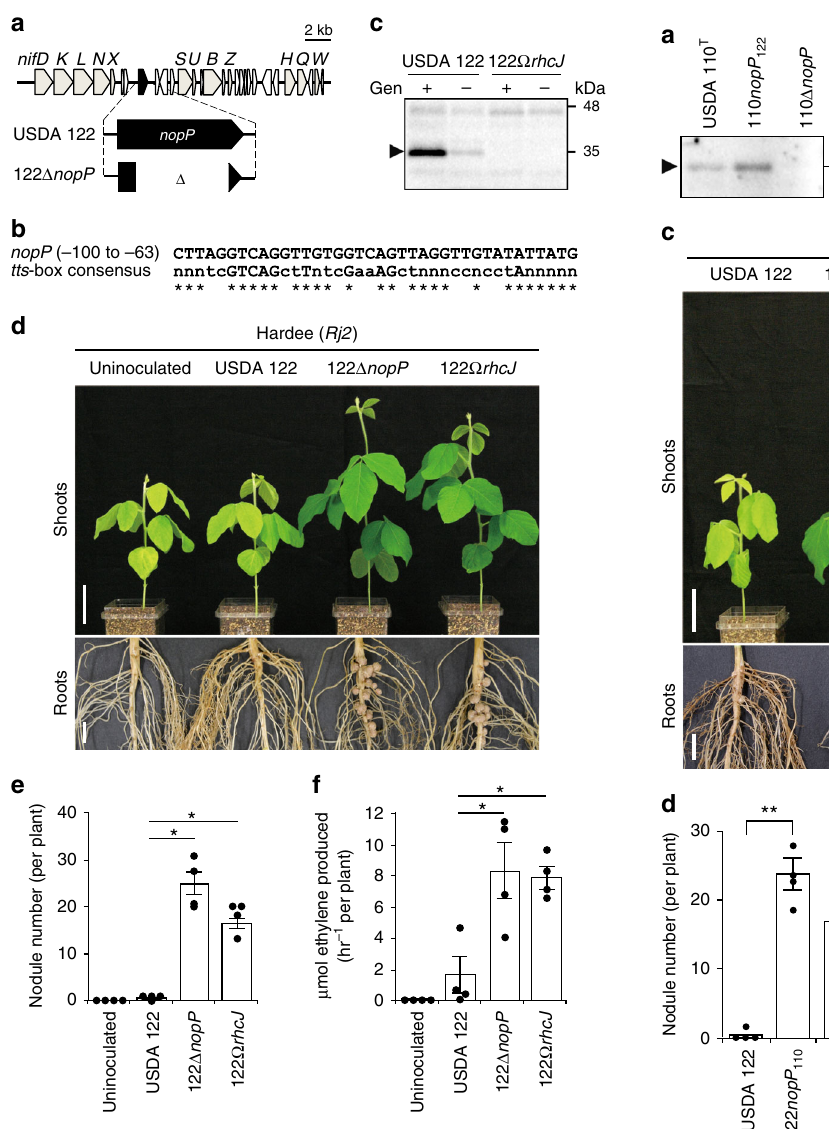
Fig. 3 Characterization of nopP in B. diazoef fi ciens USDA 122. a Organization of nopP and its fl anking regions in USDA 122 and 122 Δ nopP . b consensus sequence 64 . Asterisks indicate identical nucleotides. c Western blotting analysis of NopP secreted into culture supernatants from USDA 122 and its mutant with inactivated T3SS (122 Ω rhcJ ). Strains were grown in the presence ( + ) or absence ( – ) of 10 μ M genistein (Gen). The position of NopP is indicated by arrow. d Shoots and roots of G. max cv. Hardee at 28 days after inoculation with USDA 122, 122 Δ nopP , or 122 Ω rhcJ . Scale bars, 5 cm (for shoots) or 1 cm (for roots). e Number of root nodules and f nitrogen fi xation activity. The data of nodule number shown are representative of three independent experiments. Error bars show SEM ( n = 4). *Signi fi cant difference from USDA 122 ( P < 0.01 by Dunnett ’ s multiple comparison test)